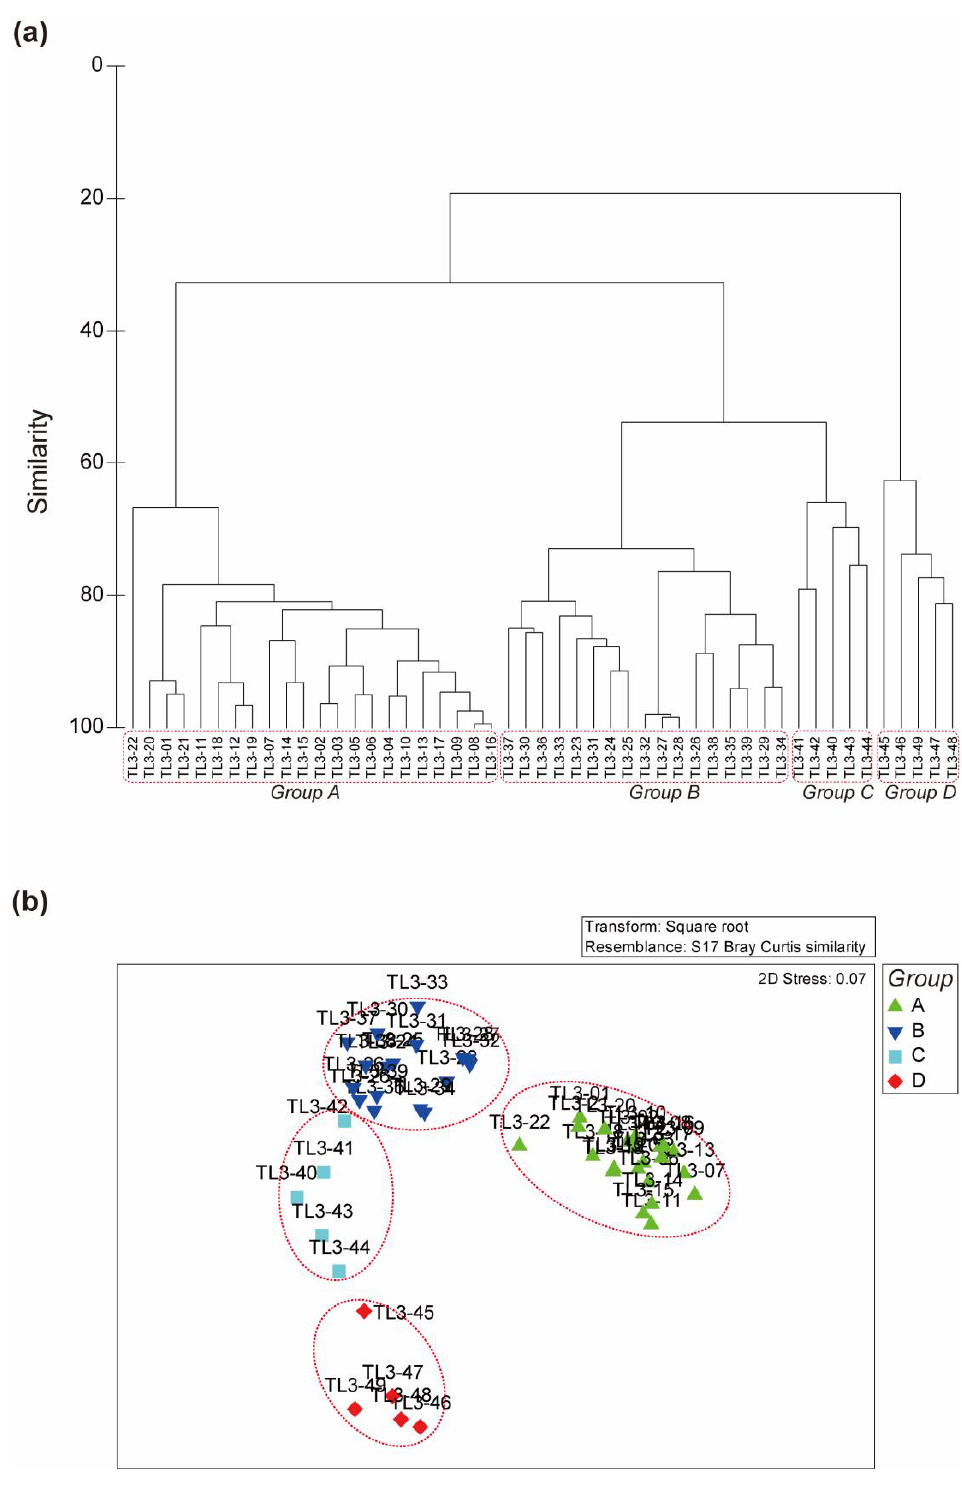
Figure 10. Multivariate analyses of the third transect (TL-3). ( a ) Dendrogram of cluster analysis. ( b ) Non-metric multidimensional scaling ordination results. Analyses based on square root transformed coverage data of benthic habitat types as determined by digital imaging analysis of the 49 photo-quadrats (i.e., sampling points) along TL-3.